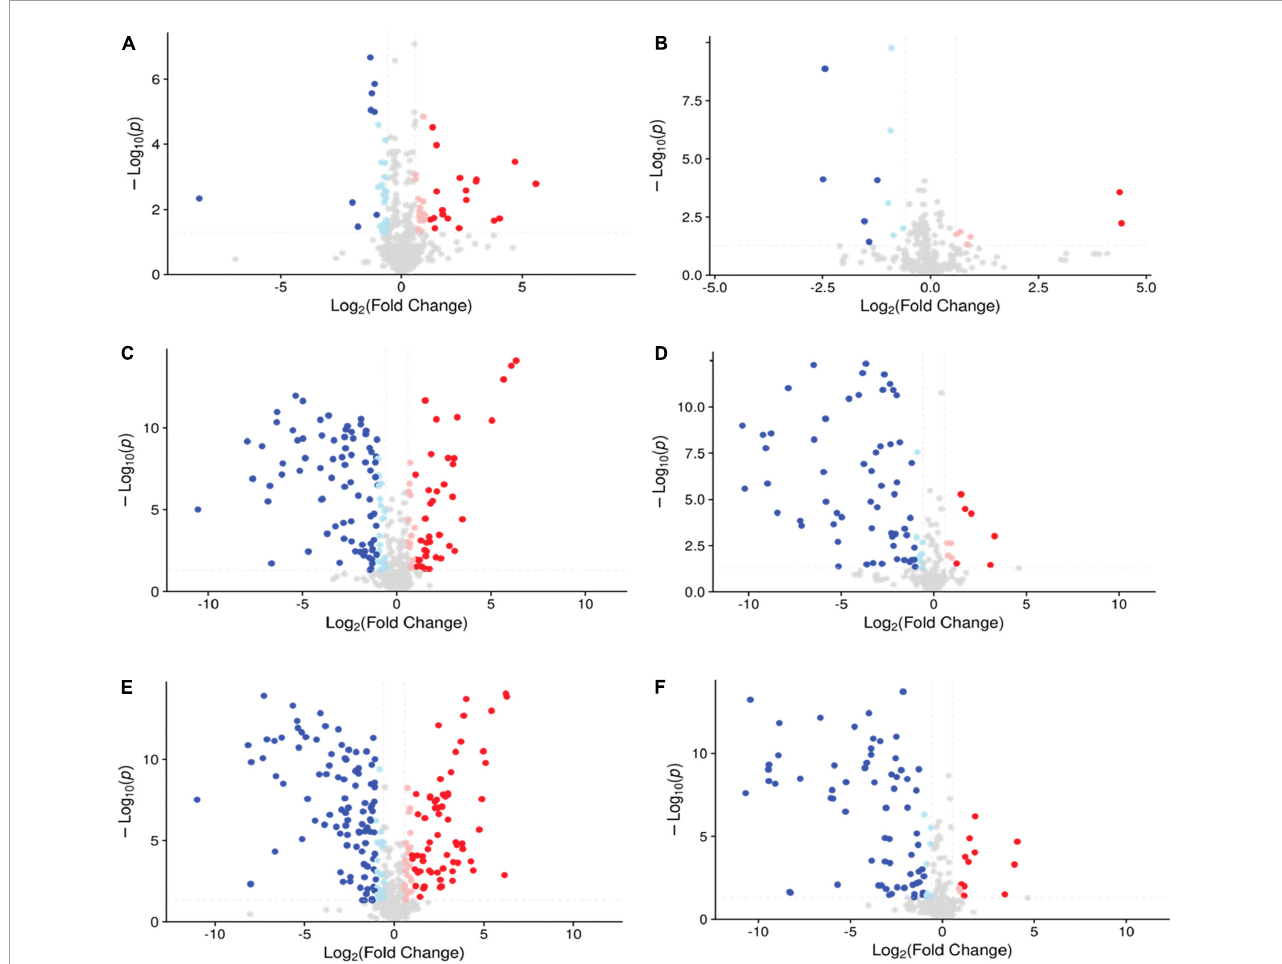
FIGURE5 The volcano plot of the comparison group AS vs. NS in negative mode (A) and positive mode (B) ; EB vs. AS in negative mode (C) and positive mode (D) ; EB vs. NS in negative mode (E) and positive mode (F) , with FC > 1.5 or FC < 0.667, and P -value < 0.05 as the screening criteria, the vertical dotted line analysis indicates log2(1/1.5) and log2(1.5); the blue point means Log2(FC) < − 1 and the light blue point means − 1 < Log2(FC) < 0, both of them indicating down-regulated metabolites; the pink point means 0 < Log2(FC) < 1 and the red point means Log2(FC) > 1, both of them indicating up-regulated metabolites; AS, aerobic fermentation supernatants; NS, anaerobic fermentation supernatants; EB, extractives of Polygonati Rhizoma before